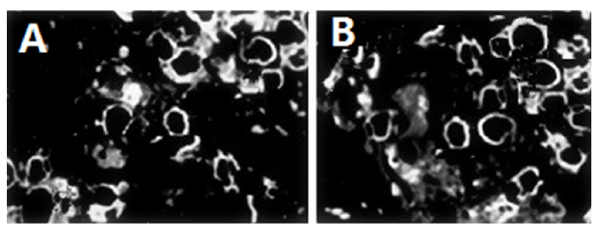
Fig. 3. CD31 immunohistochemical staining results of Group